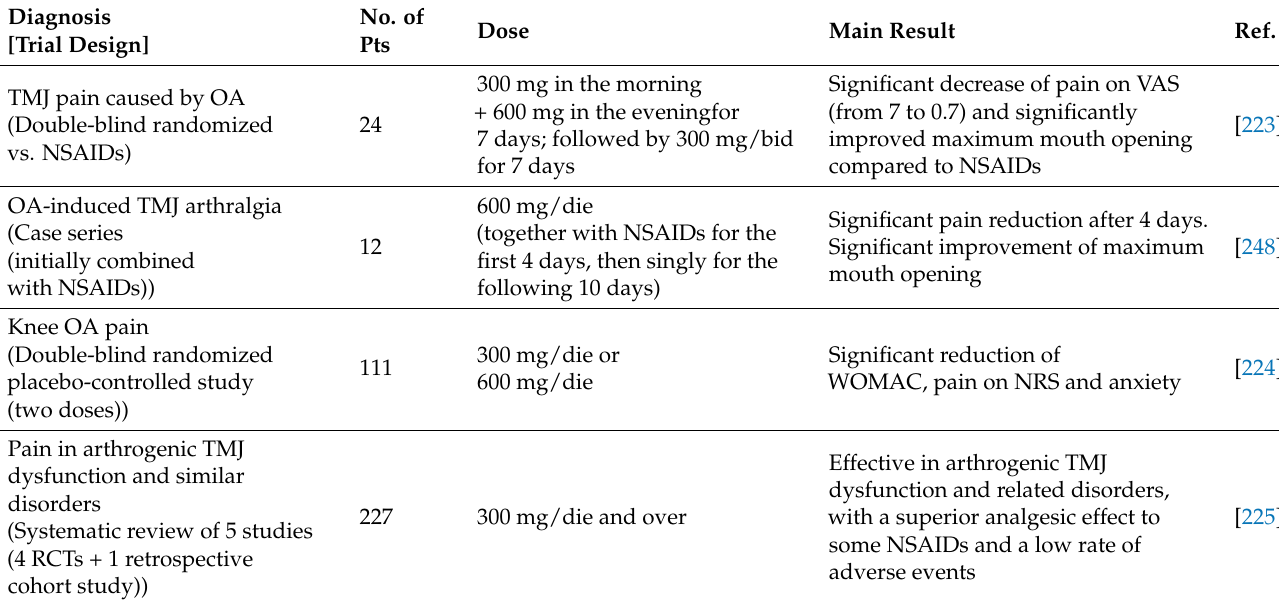
Table 6. Pain relieving effect of micro-PEA (i.e., PEA-m or PEA-um) on chronic mixed pain: overview of clinical trials in chronological order.